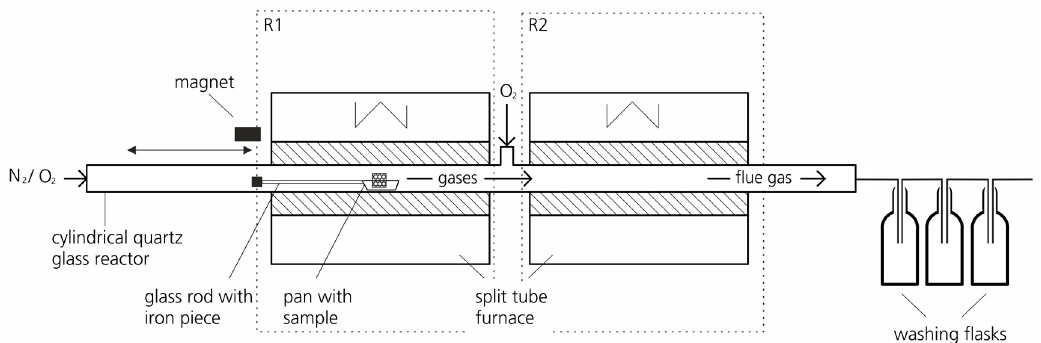
Figure 1. Experimental setup of a two-stage system for fluorine release analysis.